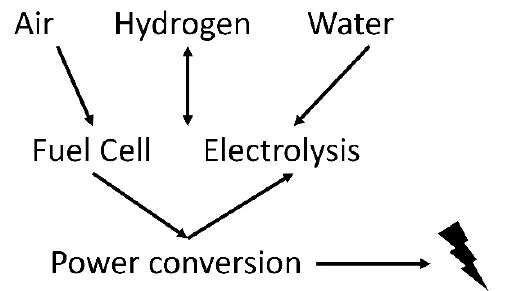
Figure 3. Schematic representation of the working of a water regenerative fuel cell system.